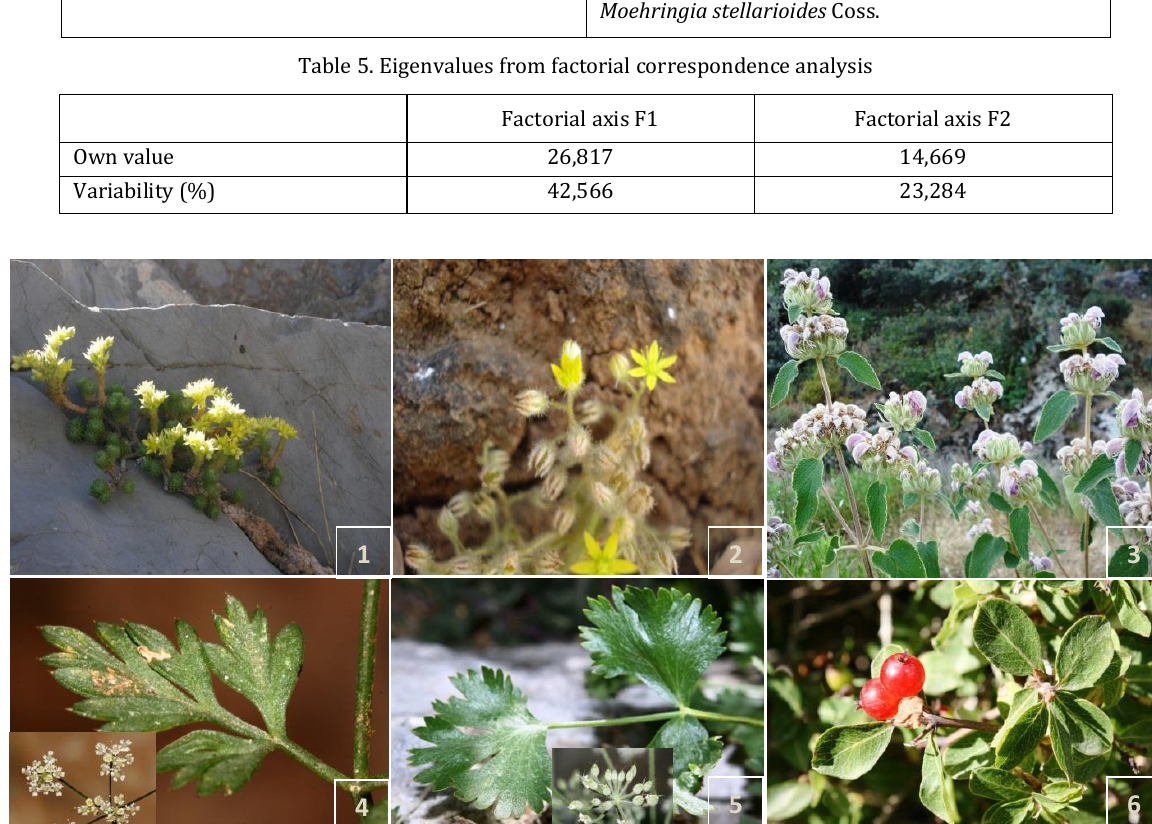
Fig. 3. Other botanical groups with a few numbers of species within the protected area of Guerrouche (Jijel) 1 – Sedum multiceps Coss. et Dur., 2 – Sedum pubescens Vahl., 3 – Phlomis bovei de Noé, 4 – Carum montanum (Coss. & Dur.) Benth. et Hook., 5 – Pimpinella battandieri Chabert, 6 – Lonicera kabylica